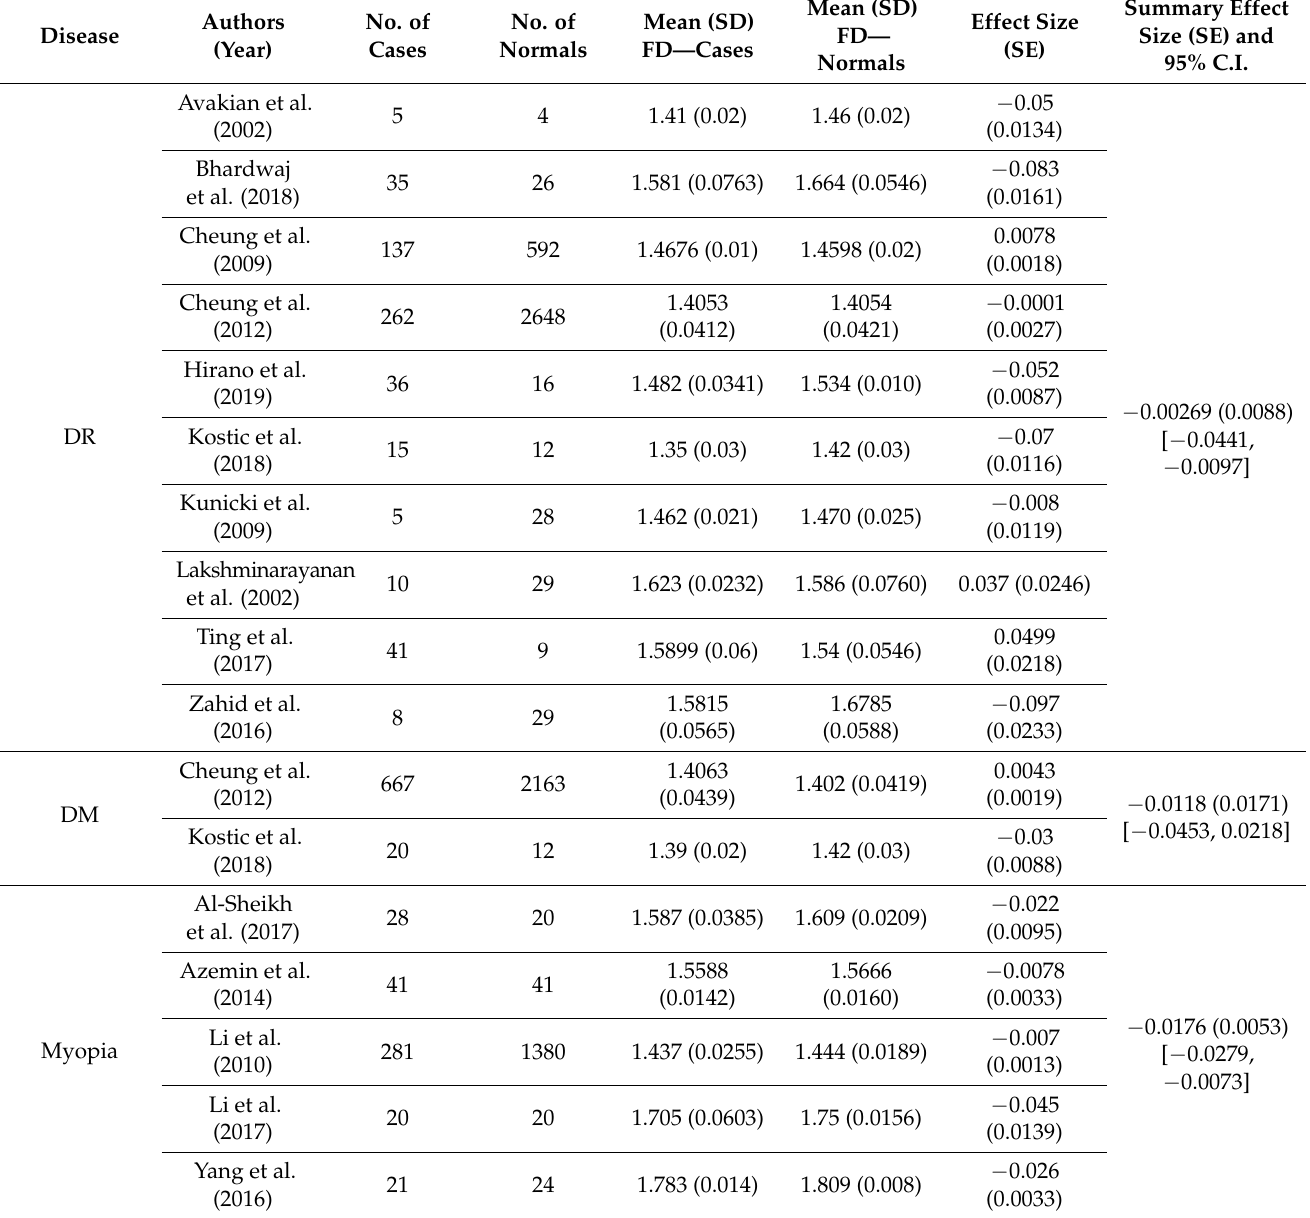
Table 4. Results of meta-analysis for retinal disease